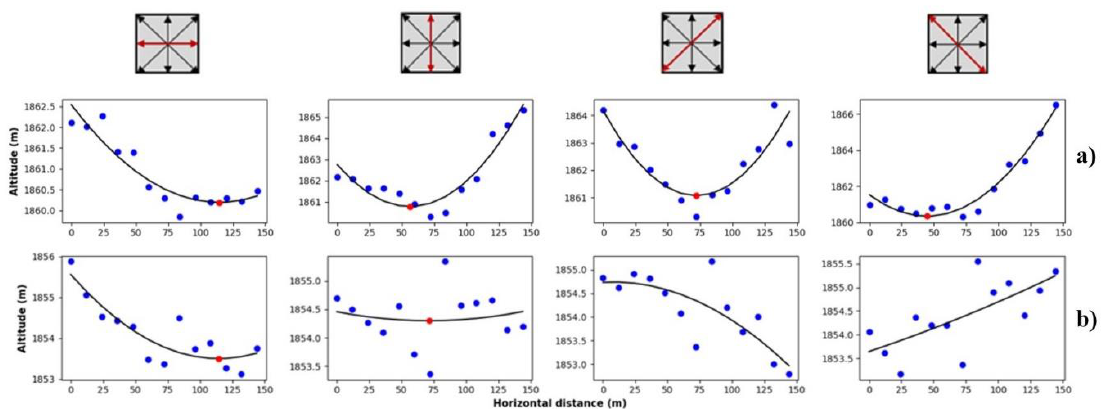
Figure 12. Detail of the point heights (in blue dots) in the four profiles and the corresponding adjusted functions (black lines) with the corresponding relative minimums (red dots) when detected. The row above ( a ) corresponds to the Square 4 in the Figure 9 and the row below ( b ) corresponds to the Square 3. Secondary gullies are also detected using the MPCA, which are characterized by their small depth than